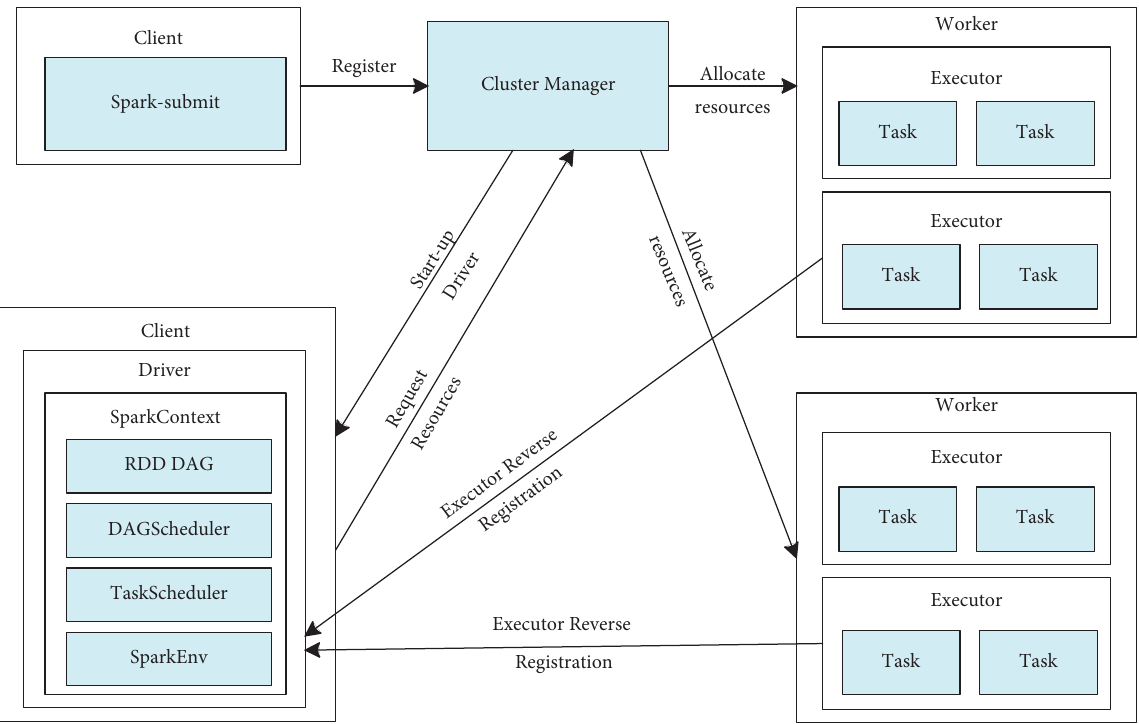
Figure 2: Spark architecture